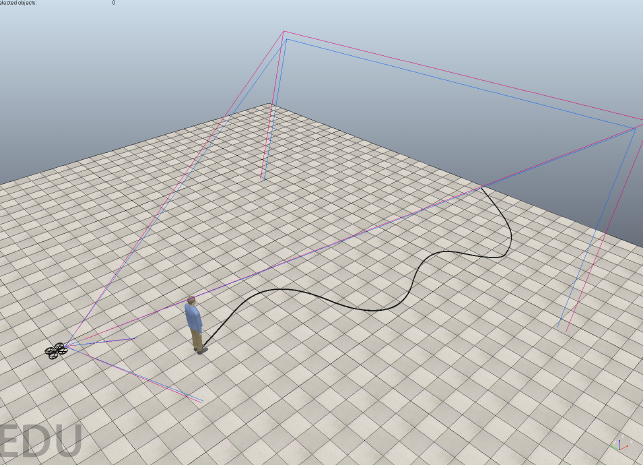
Figure 2. V-REP based virtual training environment for the quadrotor’s active tracking